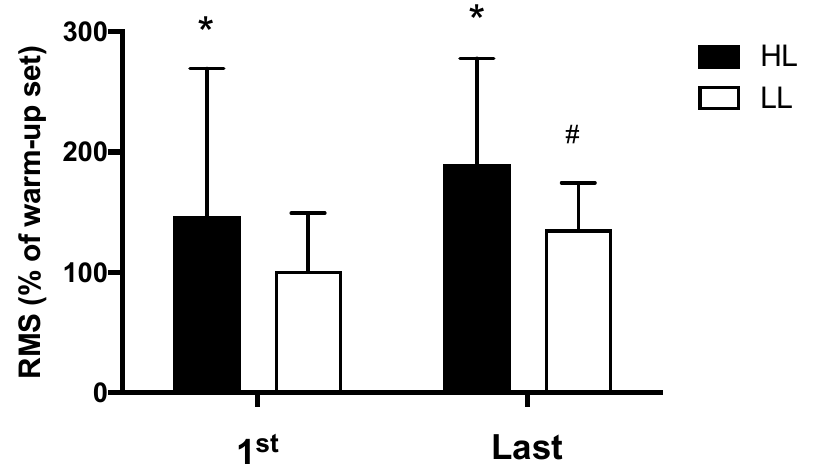
Figure 4. Amplitude of the electromyographic signal, RMS: normalized root mean square (percentage of the warm-up set used for normalization), HL: high-load resistance training, LL: low-load resistance training, 1st: first training session, Last: last training session. * p < 0.05 compared with the LL at the same period. # p < 0.05 compared with 1st for LL.